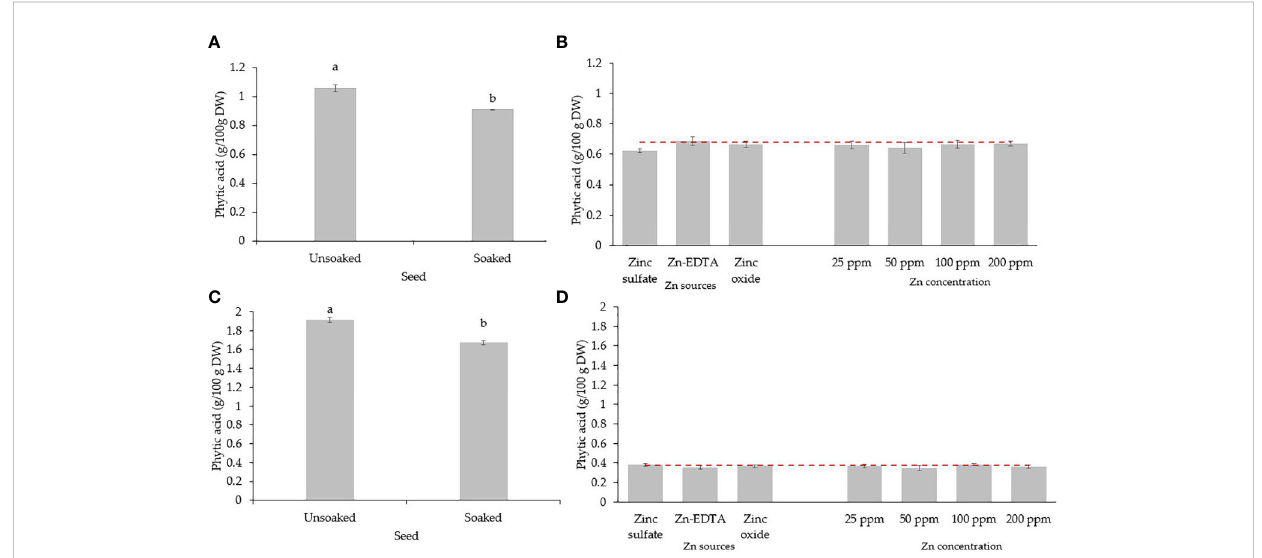
FIGURE 5 Seed soaking effect on phytic acid (g/100 g DW) content in seeds (A) and microgreens (B) of pea, and seeds (C) and microgreens (D) of sun fl ower. Vertical bars indicate average values and the standard error. Different letters indicate signi fi cant differences at p = 0.05 by the Fisher LSD test. The dashed line indicates the average value of the untreated